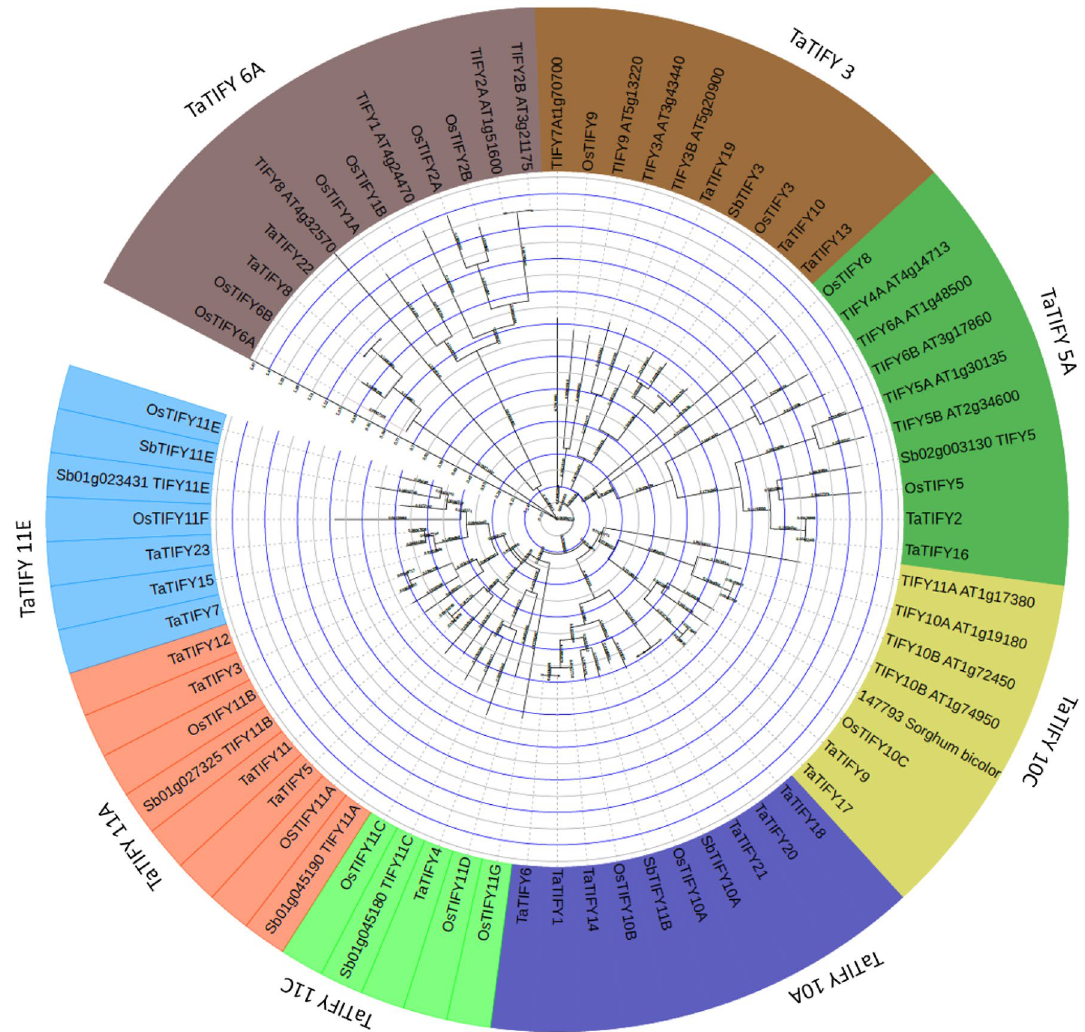
Figure 2. Phylogenetic relationships of 23 TaTIFY TF proteins of wheat and their evolutionary relationship with Arabidopsis and Oryza sativa